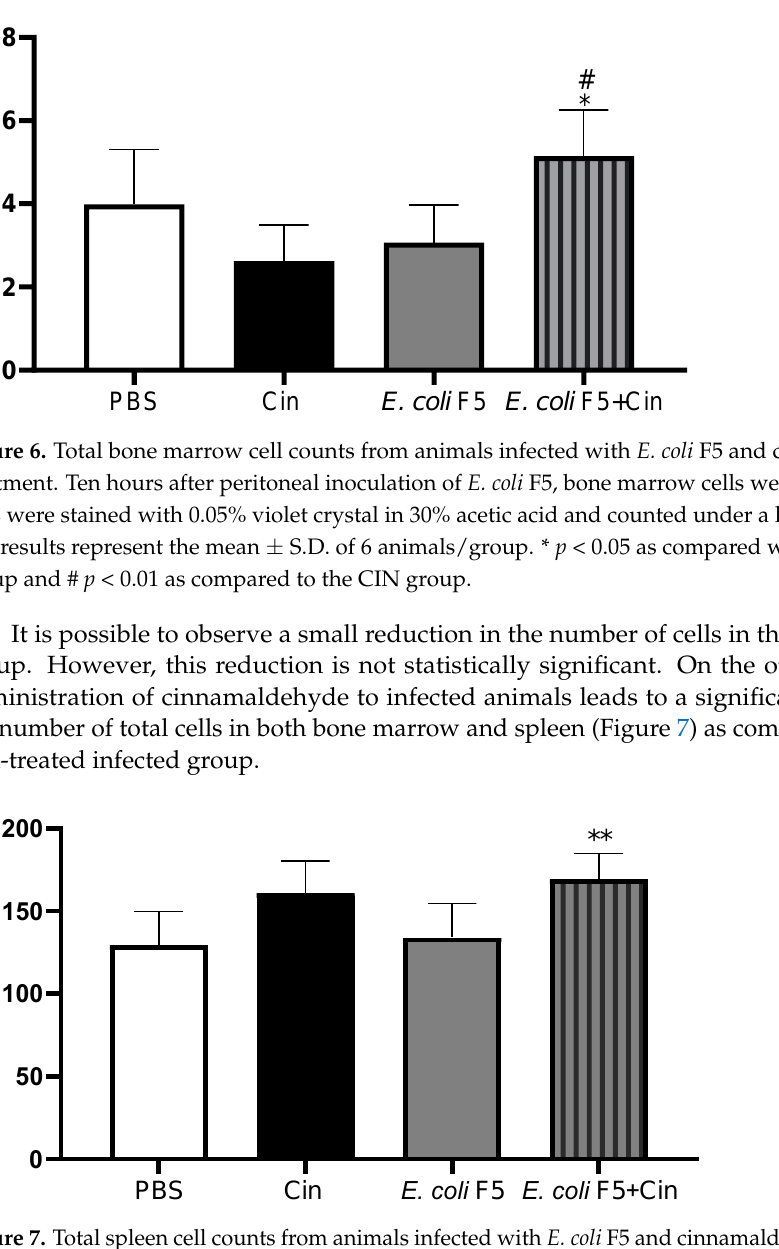
Figure 7. Total spleen cell counts from animals infected with E. coli F5 and cinnamaldehyde treatment. Ten hours after peritoneal inoculation of E. coli F5, spleen cells were obtained by removing and macerating the organ using PBS. The cells were stained with 0.05% violet crystal in 30% acetic acid and counted under a light microscope. The results represent the mean ± S.D. of 6 animals/group. ** p < 0.05 as compared with the E. coli F5 group.